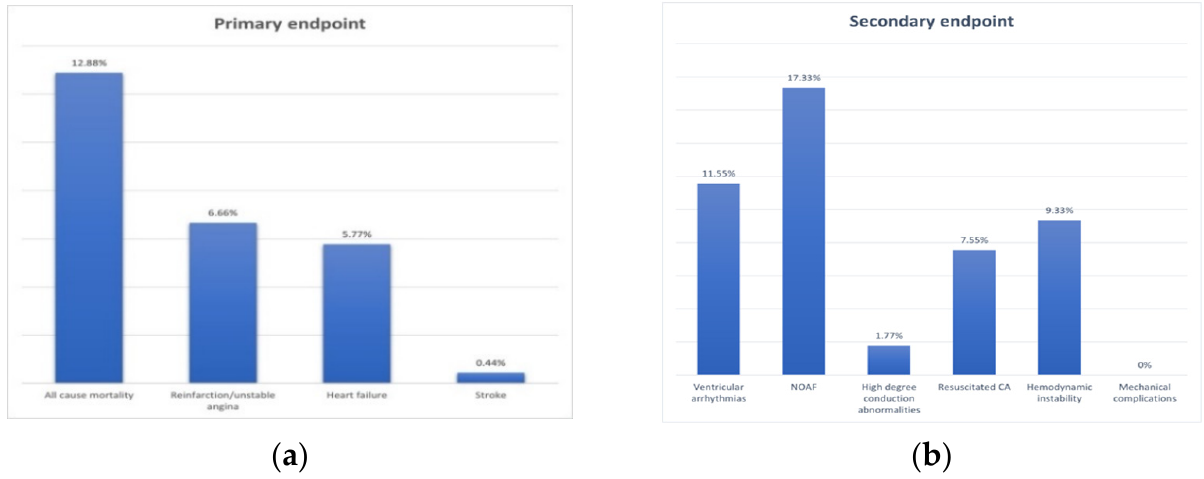
Figure 1. Distribution of primary ( a ) and secondary ( b ) study end-points for the overall study population.